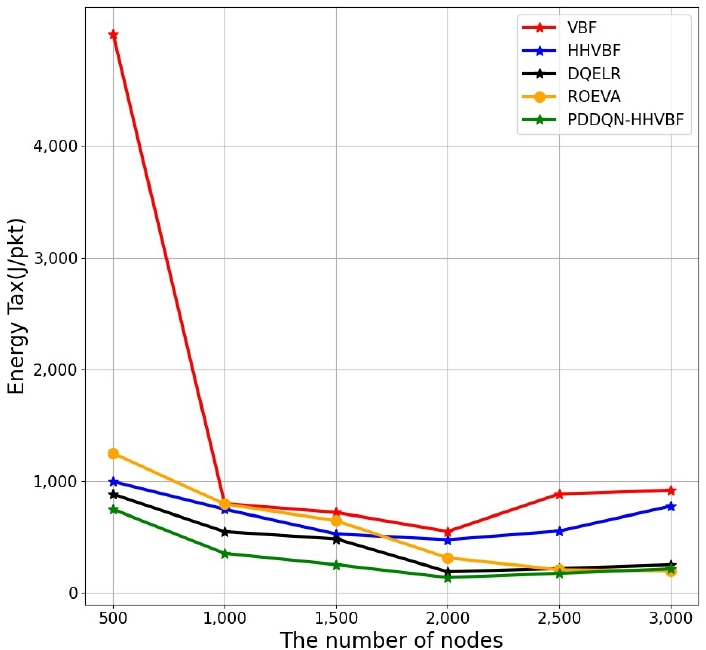
Figure 17. The energy tax of VBF, HHVBF, DQELR, ROEVA, and PDDQN-HHVBF protocol in different number of network